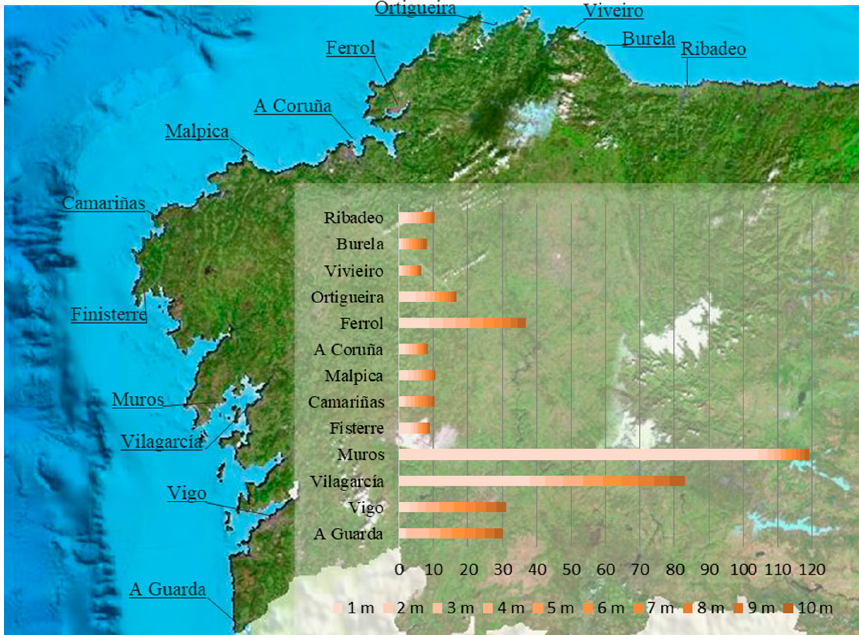
Figure 4. Inundation area (km 2 ) in relation to flood level scenario (m). Source: Based on data supplied by IHCantabria [72].